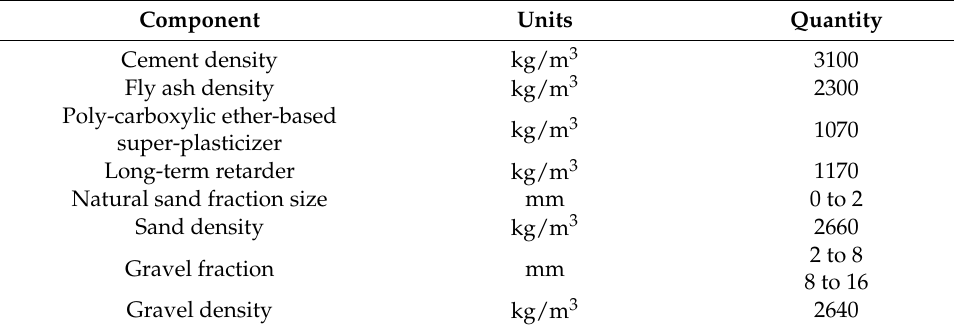
Table 1. Concrete component